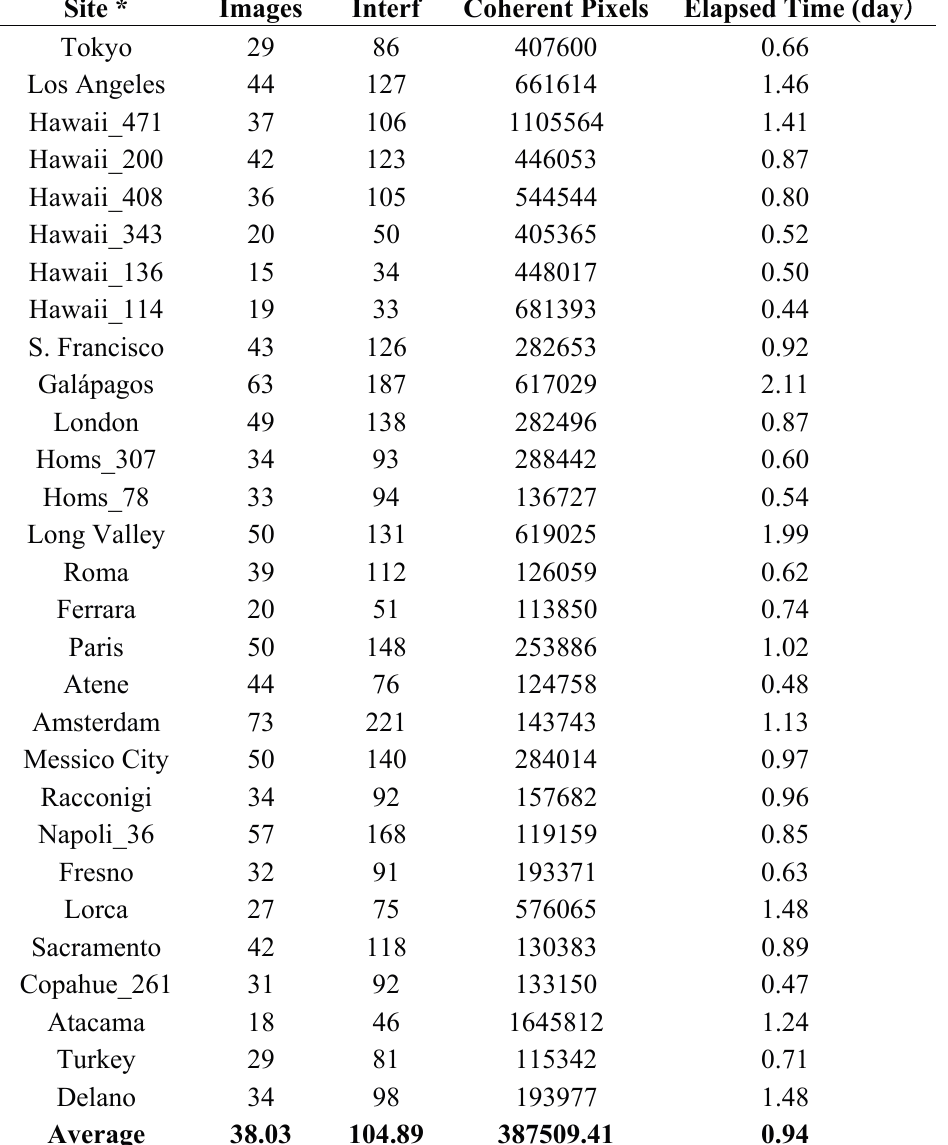
Table 2. ENVISAT SAR data sets processed through the P-SBAS web tool during the 6-month testing period January-June